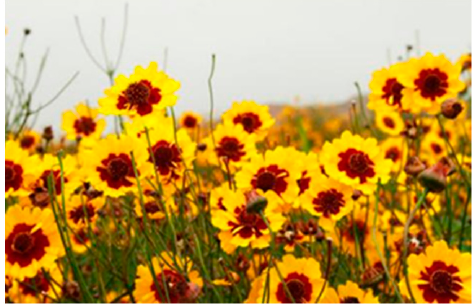
Figure 3. Kunlun snow chrysanthemum (Coreopsis tinctoria Nutt.).